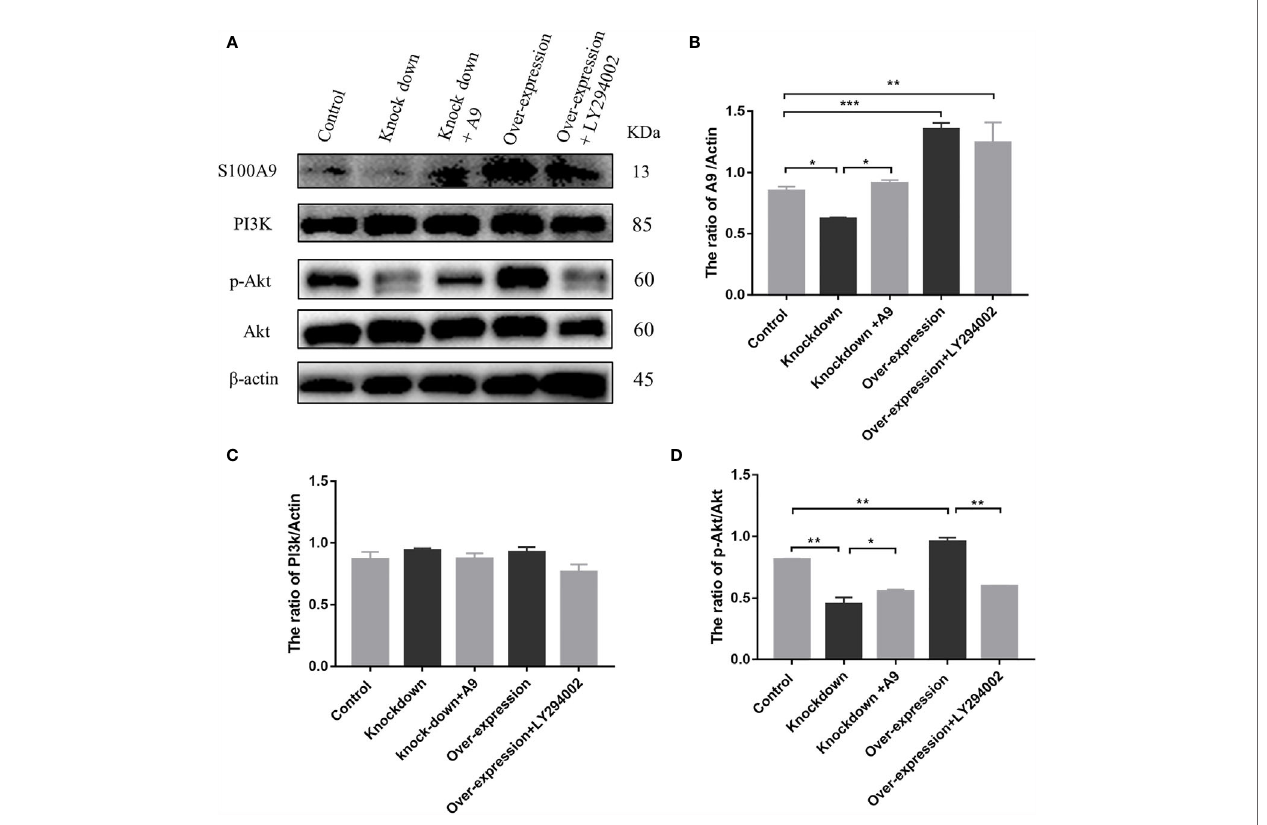
FIGURE 4 | S100A9 treatment activates PI3K/Akt pathway in Raw 264.7 macrophage cells. (A) Western blot results and quanti fi cation data of S100A9, PI3K, p- Akt, and Akt expression in different groups. Quanti fi cation data of Western blot analysis results for the ratio of (B) S100A9/Actin, (C) PI3K/Actin, and (D) p-Akt/Akt. Data are presented as mean ± standard error ( n =2 – 3); *P < 0.05, **P < 0.01, ***P < 0.001; comparisons between groups using one-way ANOVA followed by Dunnett ’ s multiple comparisons